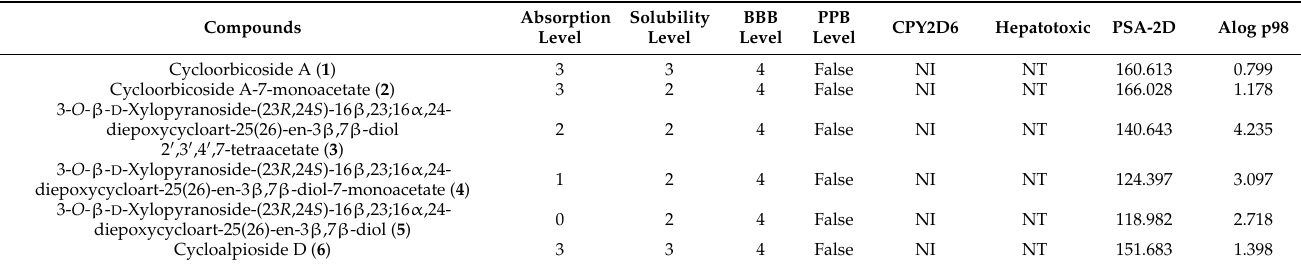
Table 4. The absorption, distribution, metabolism, excretion, and toxicity (ADMET) predictions for the fifteen selected